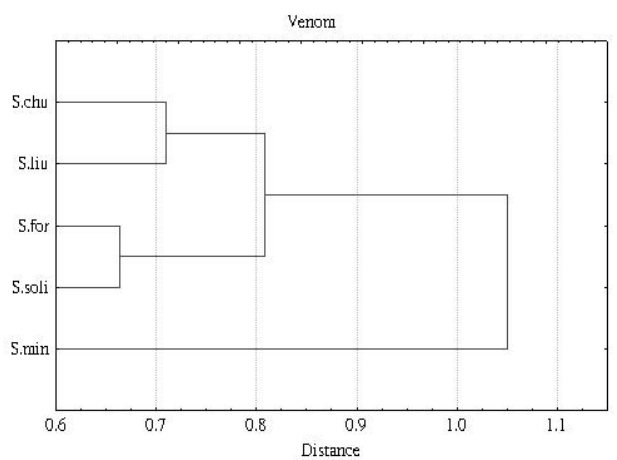
Fig 6. Cluster analysis based on the chemical characters. (Single link, 1-Pearson r). (S.for: S. formosensis ; S.min: S. minutula ; S.chu: S. chuchihensis ; S.liu: S. liukueiensis ; S.soli: S. solifontis